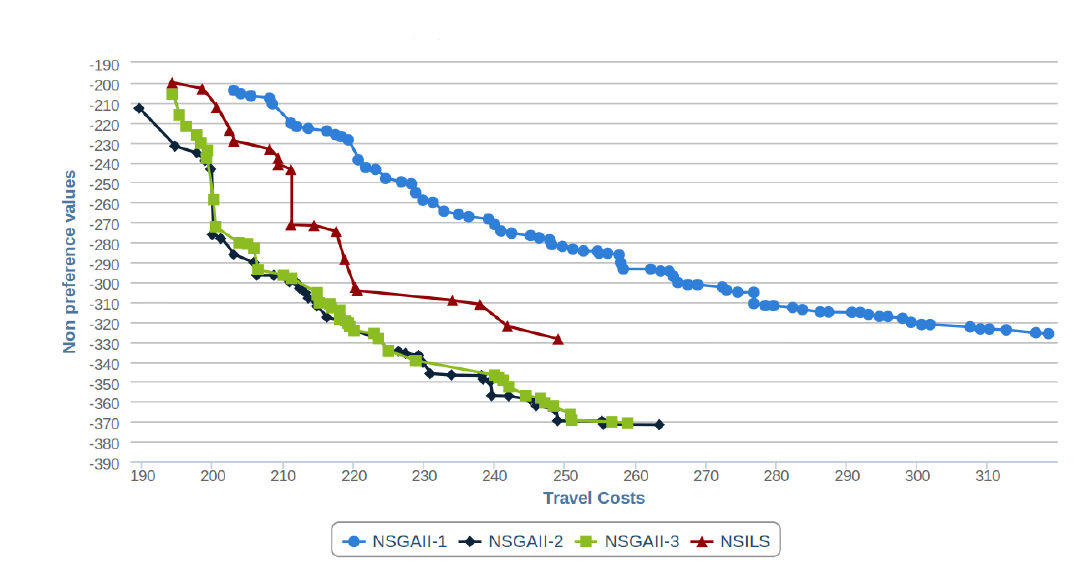
Figure 6. Impact of local search for Instance 25 on NSGAII .